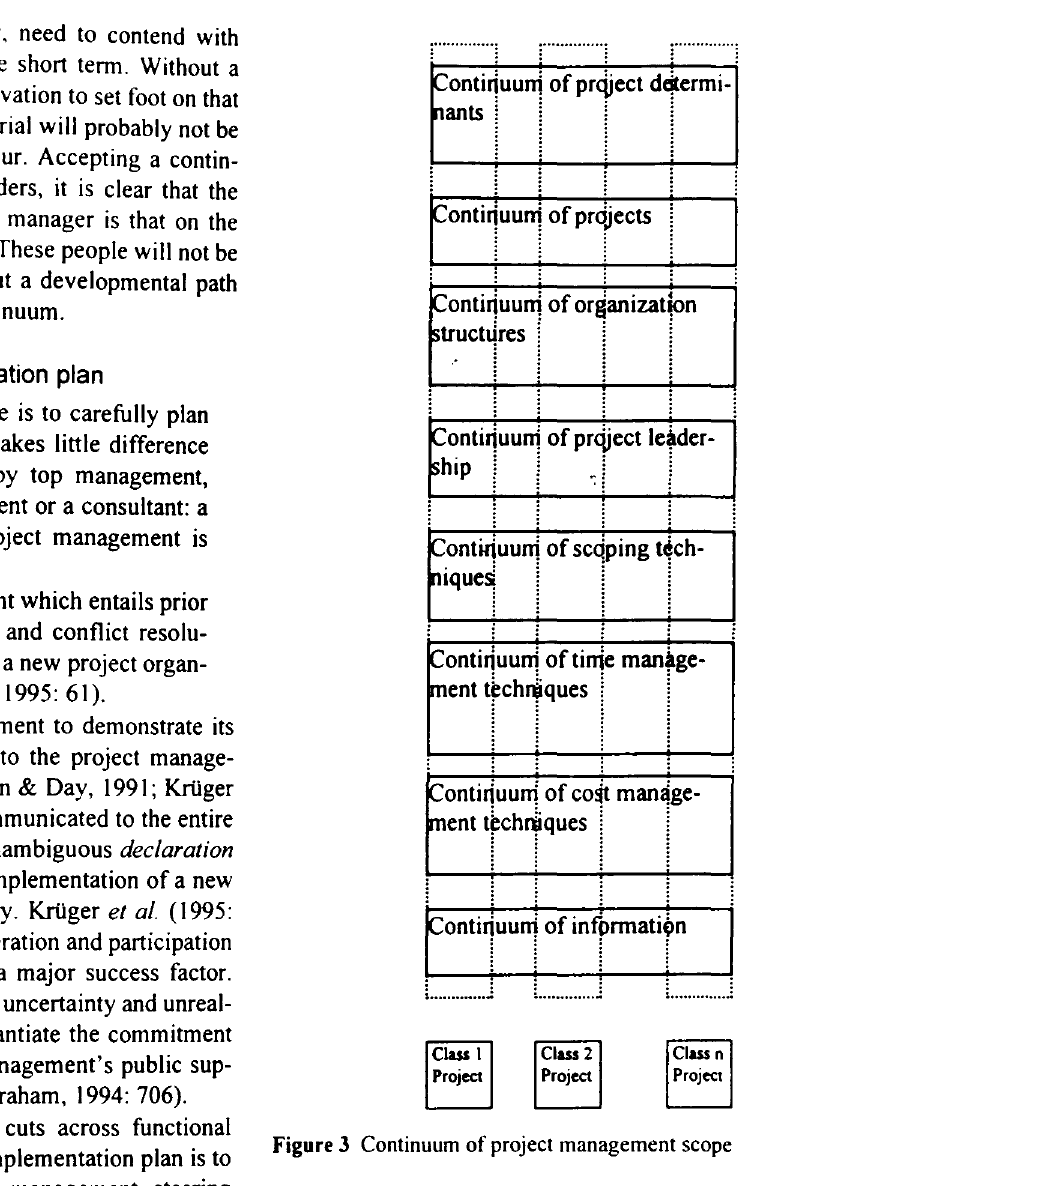
Figure 3 Continuum of project management